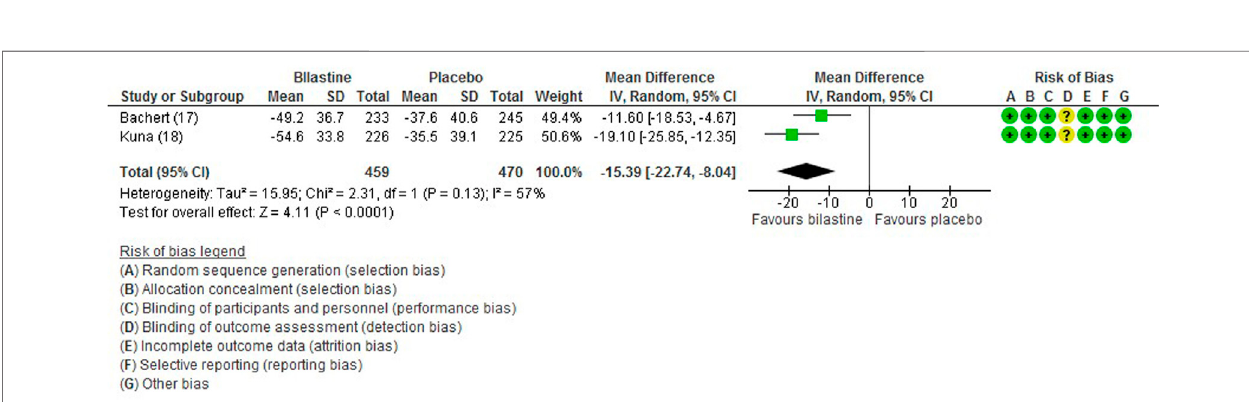
Frontiers in Pharmacology |